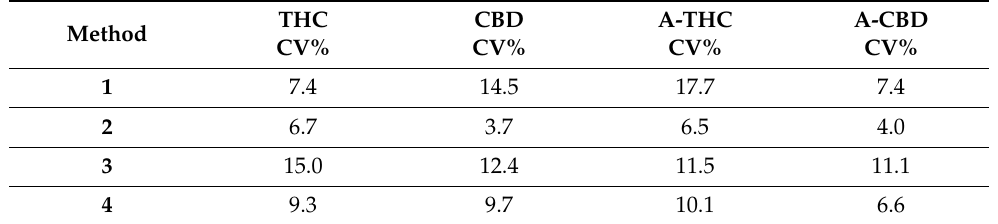
Table 2. (CV%) of the different dilution schemes, with pipettes 2.